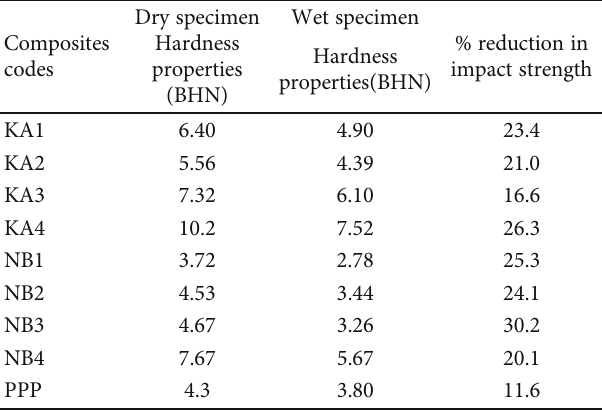
Figure 6: Comparison of Hardness properties of KOH and NaOH treated fi ber-reinforced composites and pure PP. Table 5: Comparison of Hardness properties of polypropylene composites under wet and dry